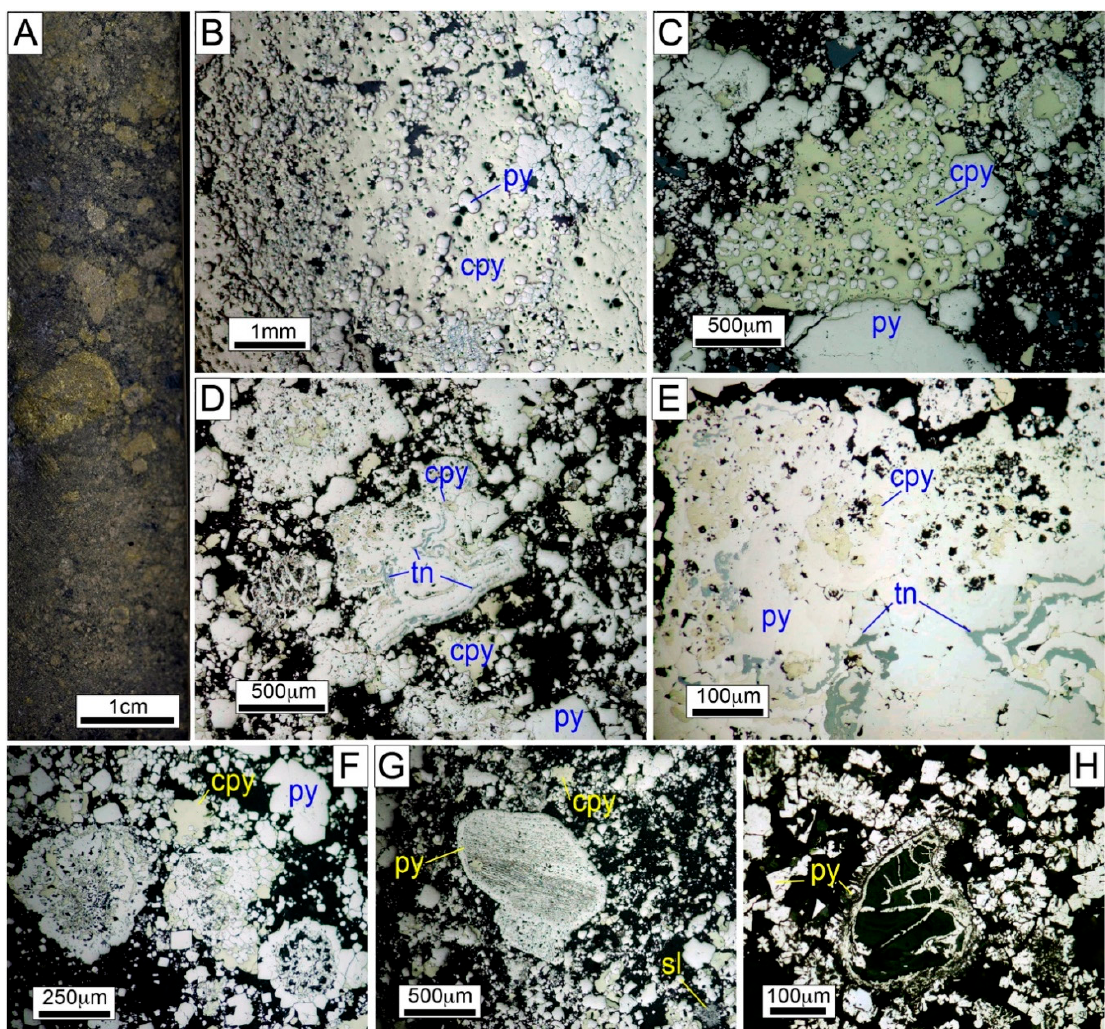
Figure 7. Hand sample photograph ( A ) and polished section photomicrographs (reflected light: B – H ) illustrating textures and mineralogy of the massive sulfide mineralization at the Romero deposit. ( A ) Breccia composed of mm- to cm-sized massive sulfide clasts with sub-angular outlines; ( B ) sub-millimeter-sized anhedral pyrite grains in a chalcopyrite-rich groundmass; ( C ) detail of a chalcopyrite–pyrite clast pinched against a pyrite clast of a similar size; ( D ) detail of an anhedral, zoned pyrite grain with abundant chalcopyrite and tennantite infillings along vuggs distributed parallel to colloform growth faces; ( E ) detail of the tennantite and chalcopyrite lining vuggs in the pyrite grain shown in ( D ); note the irregular margins and the floriform, both radiating and concentric textures, probably corresponding to putative atoll structures, within the pyrite in the outer growth bands; ( F ) in these pyrite grains, a spongy, inclusion-rich core was overgrown by compact subhedral to euhedral pyrite crystals; the porosity is filled with gangue minerals (mostly quartz) and chalcopyrite; ( G ) pyrite grain with an inner spongy, cellular texture overgrowth by a thin layer of pristine pyrite; ( H ) micro-fauna shell replaced by pyrite included in a matrix rich in pyrite showing dendritic, branchy and spongy textures. Abbreviations: cpy = chalcopyrite; sl = sphalerite; tn = tennantite; py = pyrite. The (lower) main Au–Ag–Cu(–Zn) zone (up to 288 g/t Au, 46 g/Ag, 13% Cu, and 10% Zn) comprises a 200-m-thick domain with a dense stockwork sulfide mineralization (Figures 8 and 9). Chalcopyrite- and gold-rich, centimeter-scale, sulfide-silica veins are conspicuous. Successive narrow subparallel layers of quartz of different colors and of sulfides (chalcopyrite + pyrite ± sphalerite) describe crustiform arrangements often with colloform and cockade textures (Figure 8A–E). On